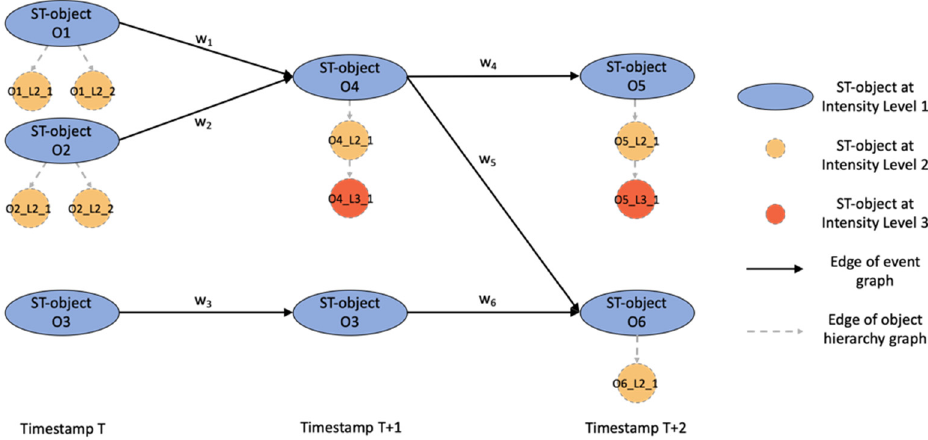
Figure 3. Spatiotemporal (ST)-event and object hierarchy represented in an event graph.